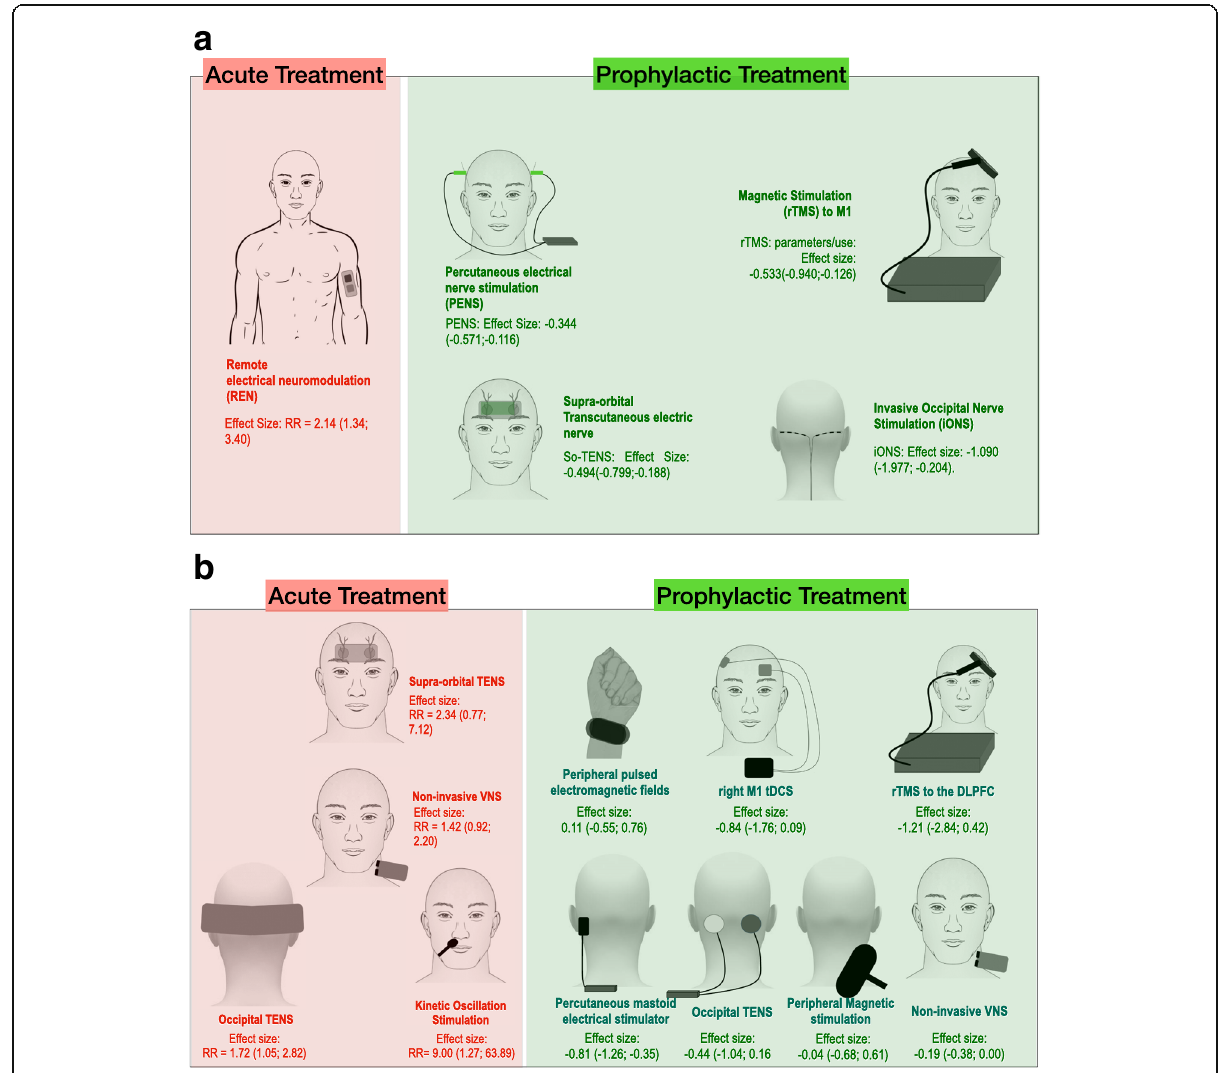
Fig. 4 Summary of neuromodulatory techniques included in the meta-analysis. a : Techniques found to be effective for acute or preventive migraine treatment according to the meta-analysis (at least 2 includable RCTs). b : Other techniques included in the meta-analysis. Effect sizes were noted as relative risk (RR) for acute treatments (the higher the RR, the more effective the method) or standardized mean difference (SMD) for preventive treatments (the more negative the SMD, the more effective the method). 95% confidence intervals were provided (minimal; maximal). rTMS: repetitive transcranial magnetic stimulation, M1: primary motor cortex, TENS: transcutaneous electric nerve stimulation. VNS: vagus nerve stimulation, tDCS: transcranial direct current stimulation Technical details from stimulation modalities cited in figure 4a: REN : parameters/use: single 20-45-minute symmetrical biphasic square pulse at 80-200Hz, pulse width of 45-400 μ s, up to 40 mA. Main side effects: local unpleasantness (common), numbness in arms and local warmth sensation (rare); [Yarnitsky 2017, Yarnitsky 2019] PENS : parameters/use: 0.18-0.32 mm x 25-40 mm needles inserted into unilateral or bilateral acupoints connected to an electro-stimulator [Taiyang EX-HN 5 for bilateral stimulation with the positive pole at the painless side of EX-HN 5 and negative pole at the painful side; for unilateral stimulation Shaoyang - "gallbladder meridian points" were used] 30-minute sessions disperse-dense waves at 2/100Hz, 5 x week for 4- 12 weeks. Main side effects: local bleeding (very common), transient leg weakness (rare) [Li H 2012, Li Y 2017] So-TENS : parameters/use: as a stand-alone or as an add-on treatment, 30x94 mm adhesive electrode on the forehead, biphasic rectangular pulse width 30 μ s, 60 Hz, max 16 mA, 20 min, extended for 3 months. Main side effects: paresthesia and pressure sensation over the electrode spot (common), somnolence (rare); [Jiang 2018, Schoenen 2013]. rTMS to M1 : parameters/use: Figure-of-eight coil, left M1 at 10Hz, 600-3000 pulses per session, stimulation at 70-80% below rest motor threshold, 1-10 sessions Effect size: -0.533(-0.940;-0.126). Main side effects: scalp discomfort (common), transient drowsiness (rare); [Misra 2013; Shehata 2016; Kalita 2016]. ONS : parameters/use: implanted lead (uni- or bilateral) perpendicular to the occipital nerves at the craniocervical junction. Parameter settings were bipolar montage, 50Hz, pulse width 330-450 µsec, bellow 10.5V amplitude. Main side effects: lead migration, local pain over the implanted pulse generator, increase in migraine (common), local infection (rare); [Saper 2010; Silberstein 2012; Serra